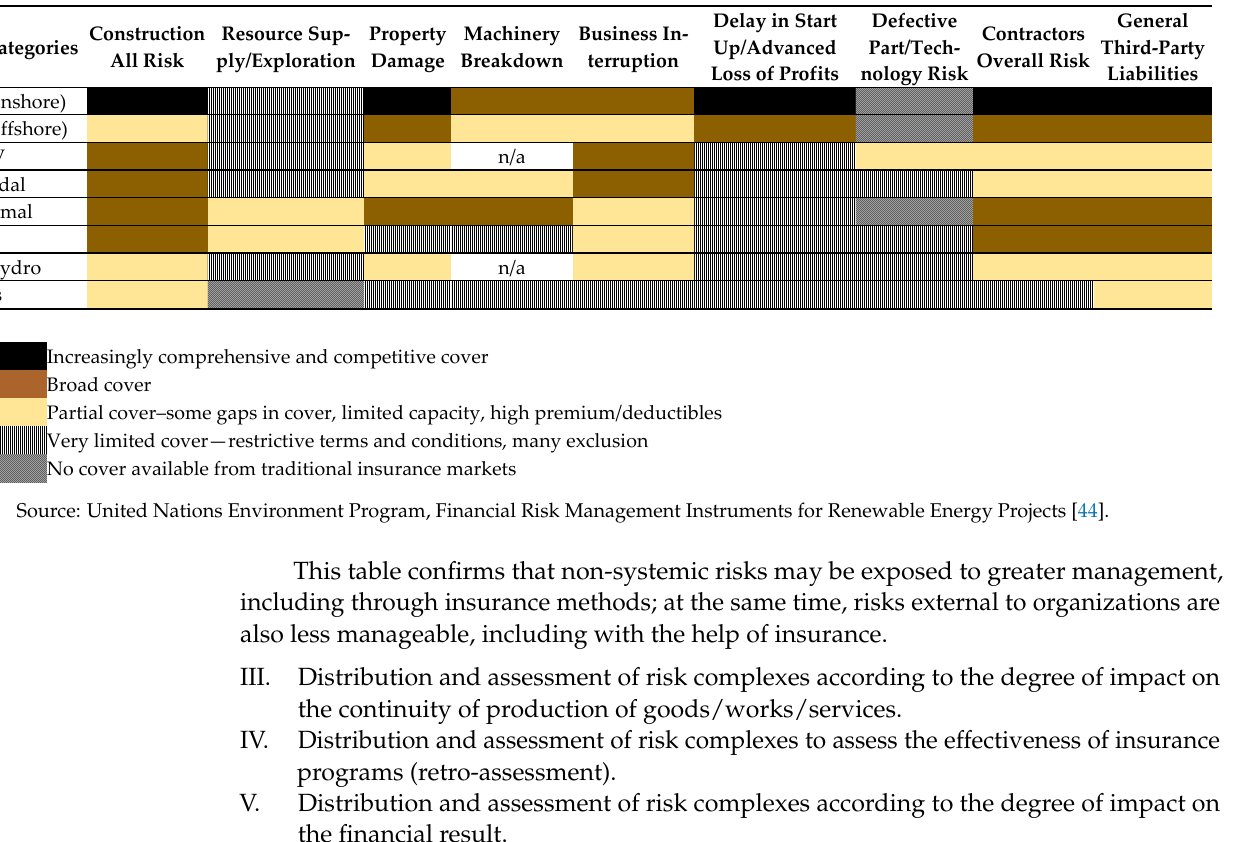
Table 3. Risks on the type of energy source.